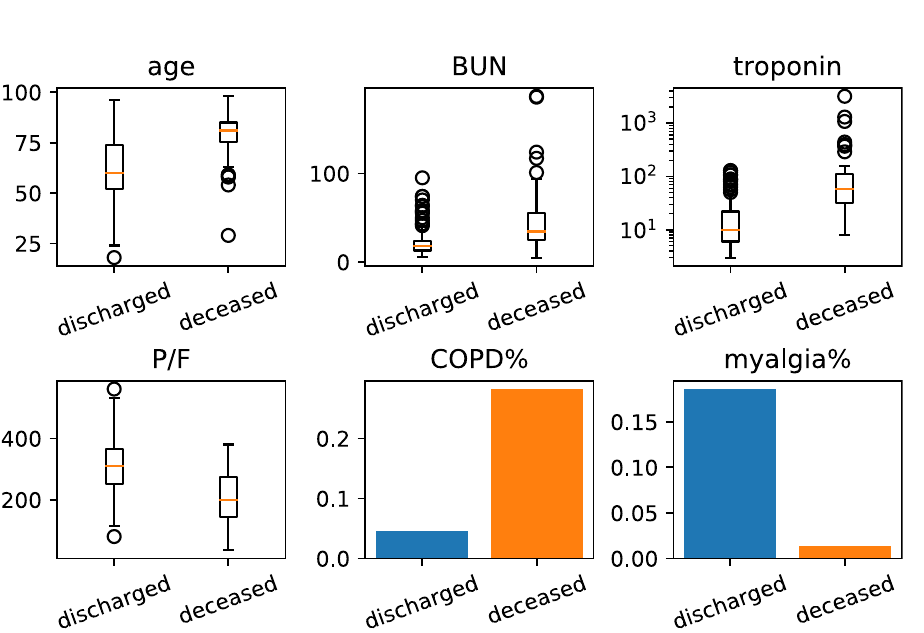
Figure 1. Selected clinical variables. Comparison of values over the two classes of